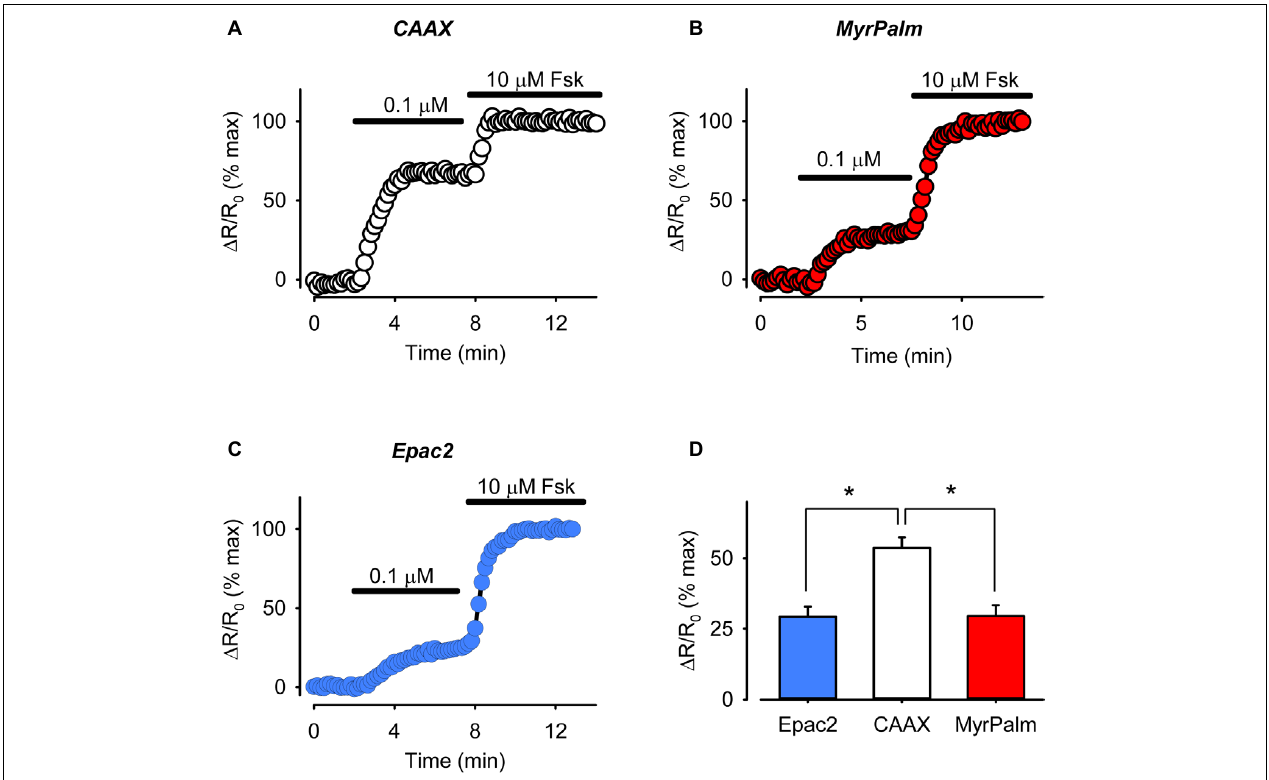
FIGURE 6 | The magnitude of cAMP responses detected in non-raft membrane domains is higher following direct AC stimulation. (A–C) Representative time course of changes in magnitude of relative FRET response ( (cid:49) R/R 0 ) in cells expressing Epac2-CAAX (CAAX, white circles), Epac2-MyrPalm (MyrPalm, red circles) and Epac2-camps (Epac2, blue circles), under control conditions and following exposure to sub-maximally (0.1 µ M) and maximally (10 µ M) stimulating concentration of the AC activator forskolin (Fsk). (D) Summary of average FRET responses to 0.1 µ M Fsk in cells expressing Epac2-camps (n/N = 8/3, blue bar), Epac2-CAAX (n/N = 8/3, white bar), and Epac2-MyrPalm (n/N = 8/3, red bar). Epac2-CAAX response to 0.1 µ M Fsk was significantly different from Epac2-camps and Epac2-MyrPalm responses ( ∗ p < 0.001, one-way ANOVA followed by Holm-Sidak method for pairwise multiple